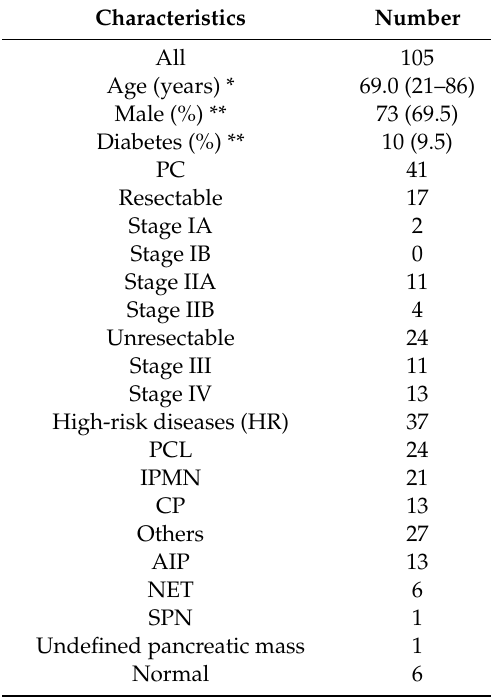
Table 3. Background characteristics of subjects in the cross-sectional